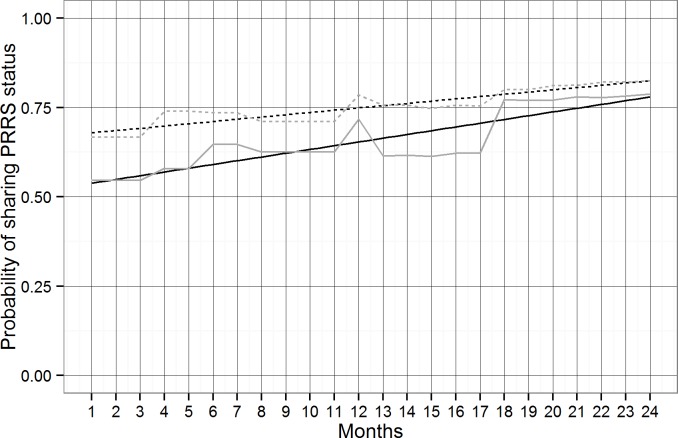
Observed (grey lines) and predicted (black lines) probably of sharing PRRS-status from July 2012 to June 2014.Continuous and dotted lines correspond to sharing PRRS-status for SS and NSS enrolled in the RCP-N212 respectively. Months from July 2012 to June 2014 are represented from 1 to 24.